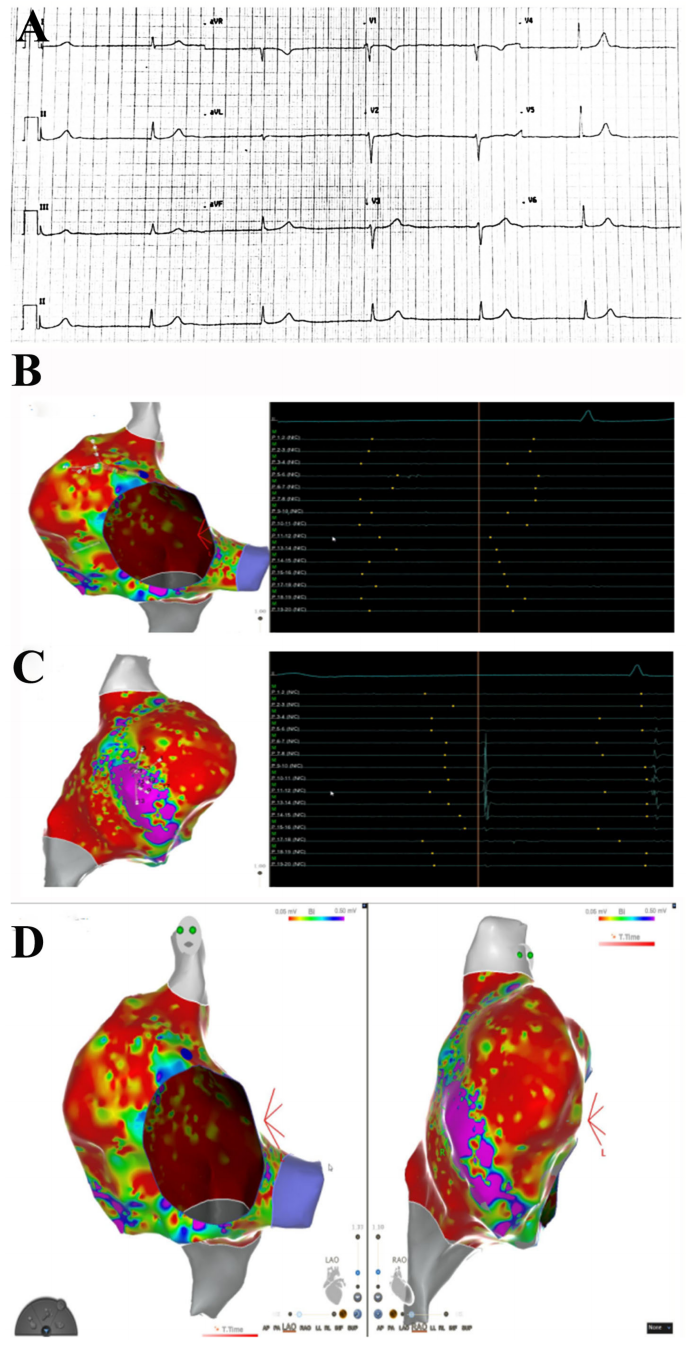
Figure 1. Right atrial substrate mapping and endocavitary electrogram recordings. ECG shows no sinus rhythm, no atrial activity at EPS. Junctional rhythm at 40 bts/min ( A ). Endocavitary